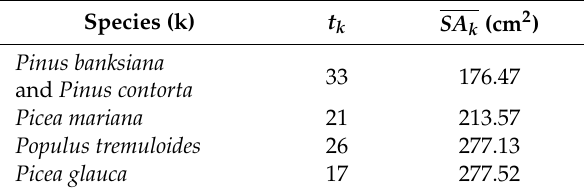
Table 1. Values of average tree-level sapwood area for each species computed with data from [31]. Only for the first three species on the list, SA k was used to estimate stand level (SA) in Equation (8b). Species (k) t k SA k (cm 2 )